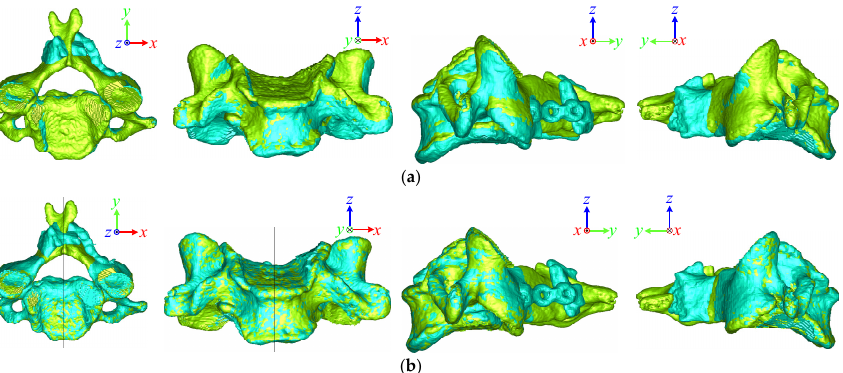
Figure 6. Superposition comparison of the ( a ) ICP and ( b ) OSP-based contouring methods for a pre- and post-surgical C4 vertebra in the cervical laminoplasty case. Figure 7 shows the superposition comparisons of pedicle screw insertion in the plan- ning (green dots) and post-surgical outcome (blue dots) of the left screw in a T9 vertebra. Table 4 lists the assessment results of surgical outcomes with the two methods in the T9 vertebra. In this case, the ICP method had a large superposition deviation in the z-direc- tion, leading to a result biased in the +z direction. It can be observed from the sagittal view that the entry point position of the ICP method was higher than that of the OSP-based contouring method, which was reflected in the assessment that the SDD deviation was 4.84 mm.